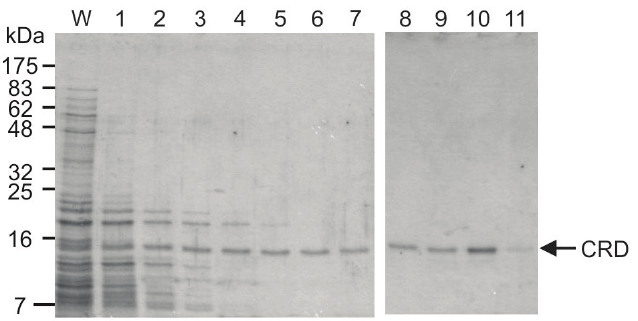
Figure 2. Purification of mincle CRD by affinity chromatography. Renatured mincle was applied to a 10-mL column of trehalose-Sepharose. Following washing with 10 mL of buffer containing Ca 2+ , the column was eluted with EDTA-containing buffer in 1-mL fractions. Aliquots (15 μ L) of the final fraction collected during the wash (W) along with the elution fractions were analyzed by SDS-polyacrylamide gel electrophoresis. Protein was visualized by Coomassie blue staining. The expected molecular weight of the CRD with the biotinylation tag is 17.8